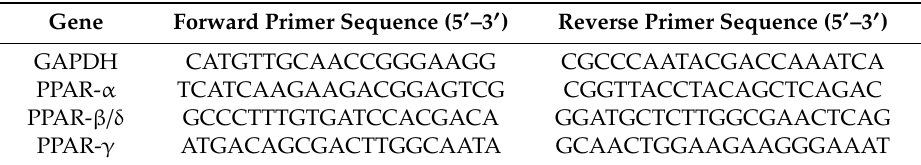
Table 1. Primers used for PPAR